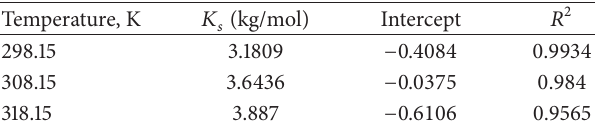
Table 7: Values of 𝐾 𝑠 and intercept of Setschenow-type equation (6) for the PEG 6000 + sodium succinate + water systems at various temperatures.